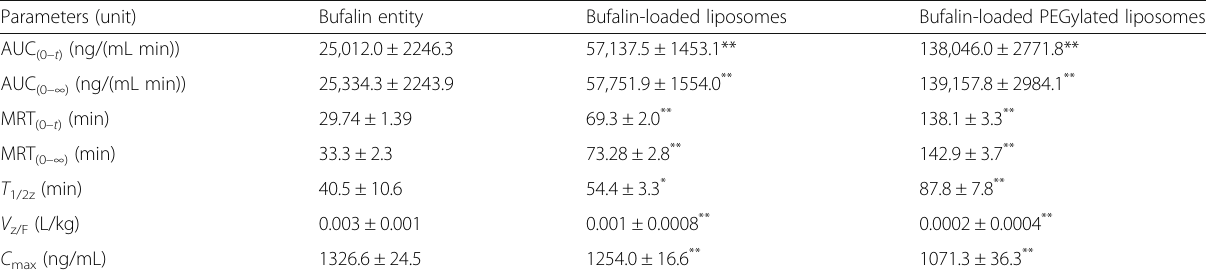
Table 3 The main plasma pharmacokinetic parameters of bufalin after intravenous administration of bufalin entity, bufalin-loaded liposomes, and bufalin-loaded PEGylated liposomes in rats ( n = 6) Parameters